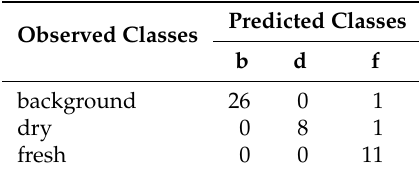
Table 3. Validation results of the Support Vector Machine (SVM) pixel classification